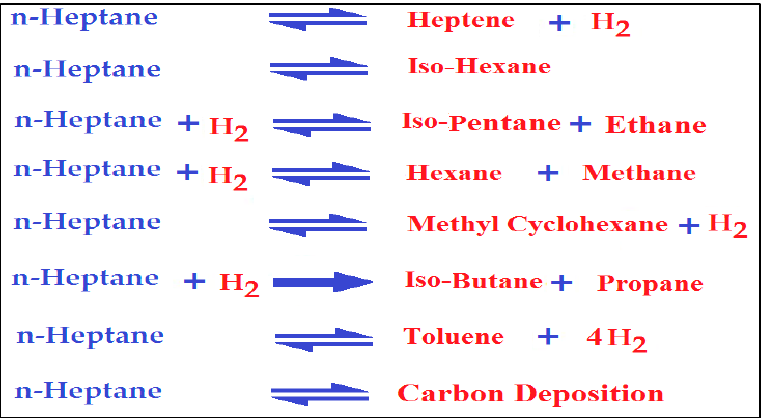
Figure 9. The suggested general reactions of the n-heptane catalytic reforming process.